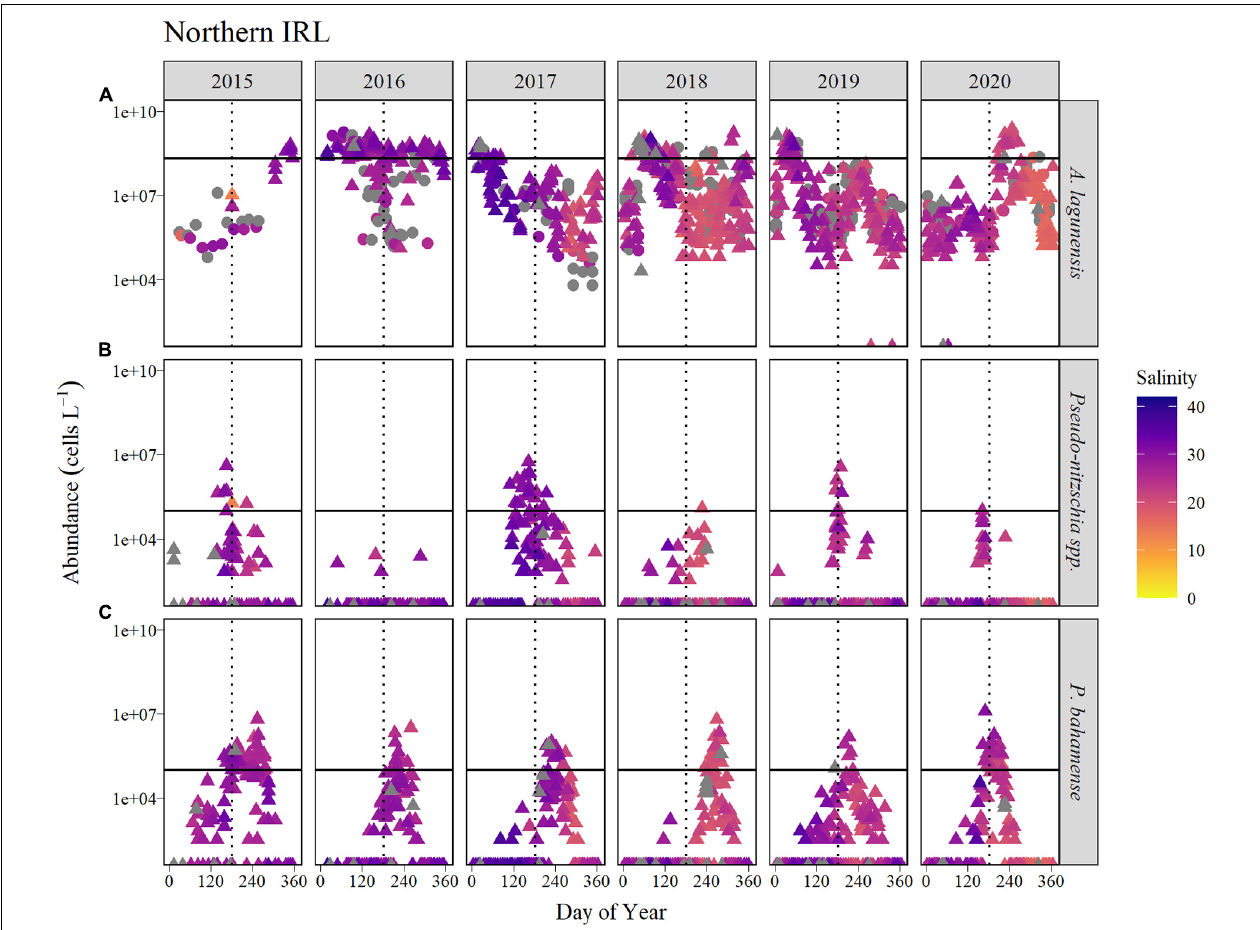
FIGURE 5 | Time course of abundance of (A) A. lagunensis cells, (B) Pseudo-nitzschia spp., and (C) P. bahamense presented on a logarithmic scale for the Northern IRL sub-basin for the years 2015 to 2020 (horizontal panels). Symbol color indicates salinity in corresponding discrete samples, shown as a gradient from the lowest salinities (orange) to the highest (blue). Gray symbols represent samples in which no discrete salinity was recorded. For A. lagunensis , abundance was determined by FWC-FWRI microscopic enumeration (filled triangles) and immunofluorescence flow cytometry (filled circles). The solid horizontal line indicates the bloom levels for each taxon ( A. lagunensis = 2 × 10 8 cells L − 1 , Pseudo-nitzschia spp., and P. bahamense = 10 5 cells L − 1 ). The vertical dotted line represents JD 182 (July 1, non-leap